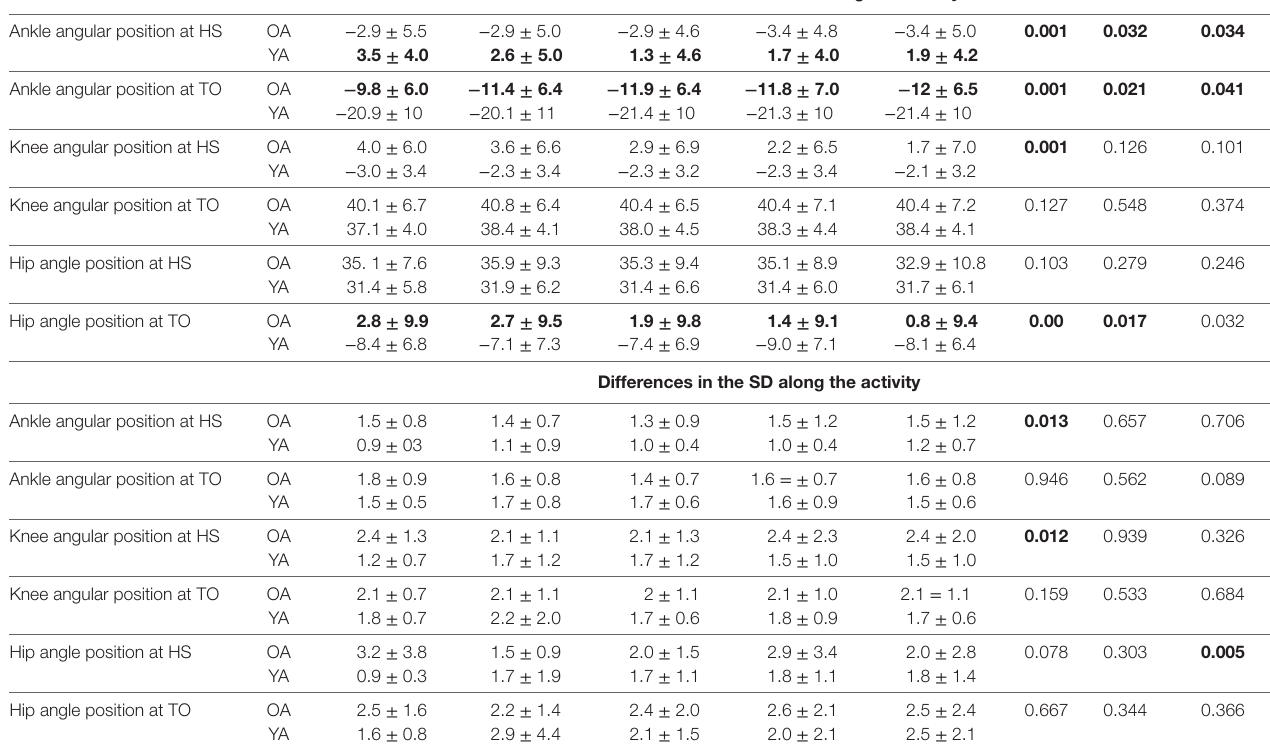
Differences in the mean values along the